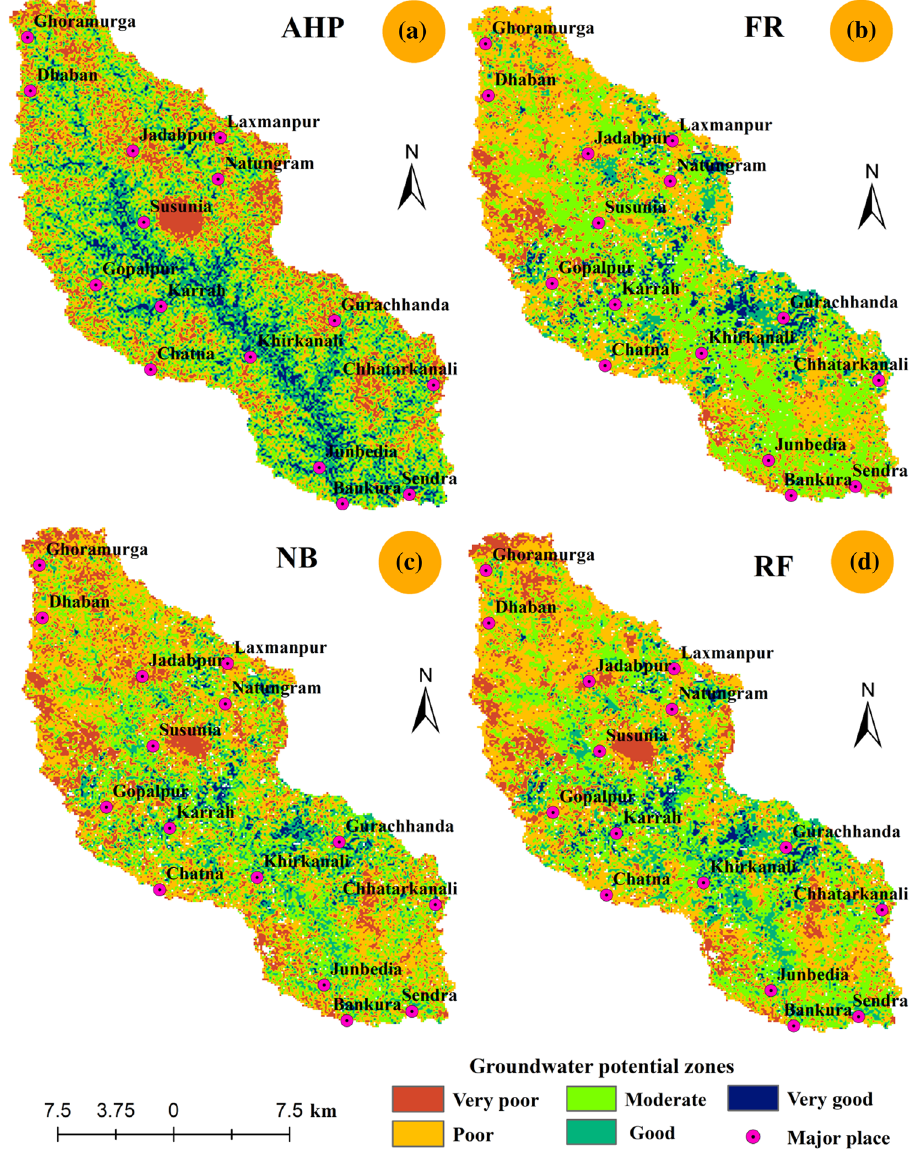
Fig. 4 Result of AHP ( a ), FR ( b ), NB ( c ) and RF ( d ) model for